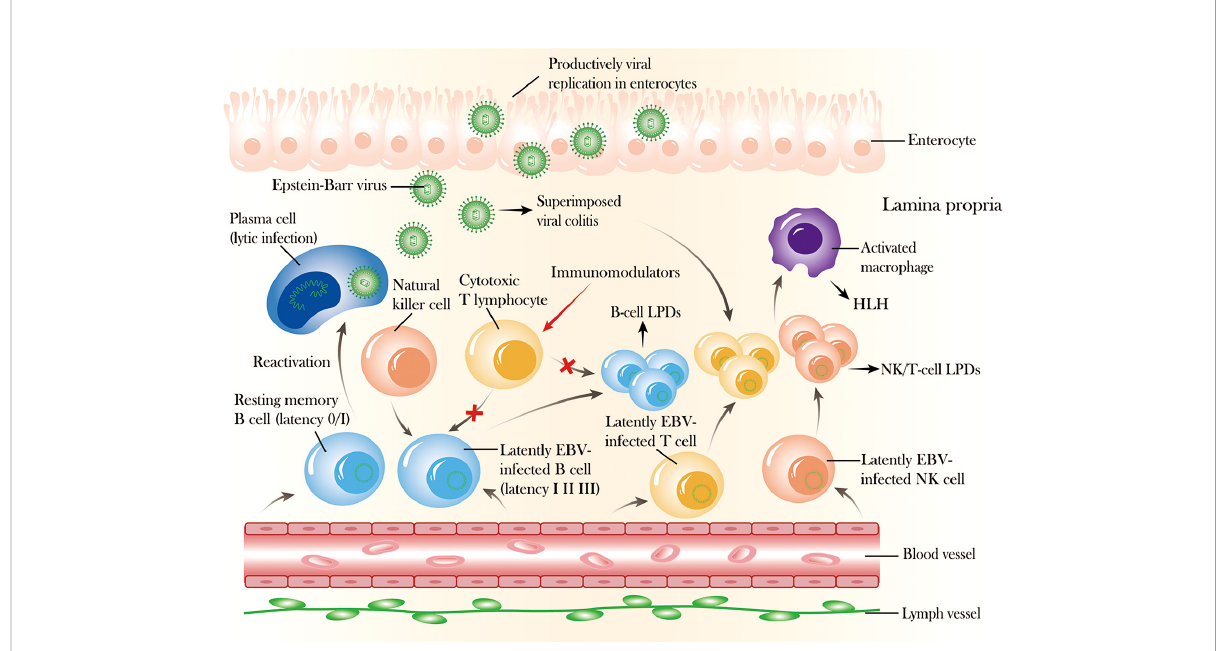
FIGURE 1 The mechanism and outcome of Epstein – Barr virus (EBV) reactivation in the intestinal mucosa. After primary infection, EBV can express different proteins (latency I, II, III) in latently infected B cells that can be recognized and controlled by cytotoxic T lymphocytes and natural killer (NK) cells, and EBV can exist permanently in resting memory B cells (latency 0/I) in healthy immunocompetent individuals. In addition, EBV can also infect NK or T cells, with prolonged latent infection. However, EBV can be reactivated from latency 0/I to cause lytic infection with active production of virus, and latently infected B or NK/T cells can undergo activation and proliferation due to EBV replication associated with the long-term use of immunosuppressive agents or biologics, which impairs cellular immunity, causing superimposed viral colitis and even B-cell or NK/T-cell lymphoproliferative diseases. Moreover, EBV infection can also spread from lymphocytes to enterocytes, where lytic replication occurs, destroying the mucosal